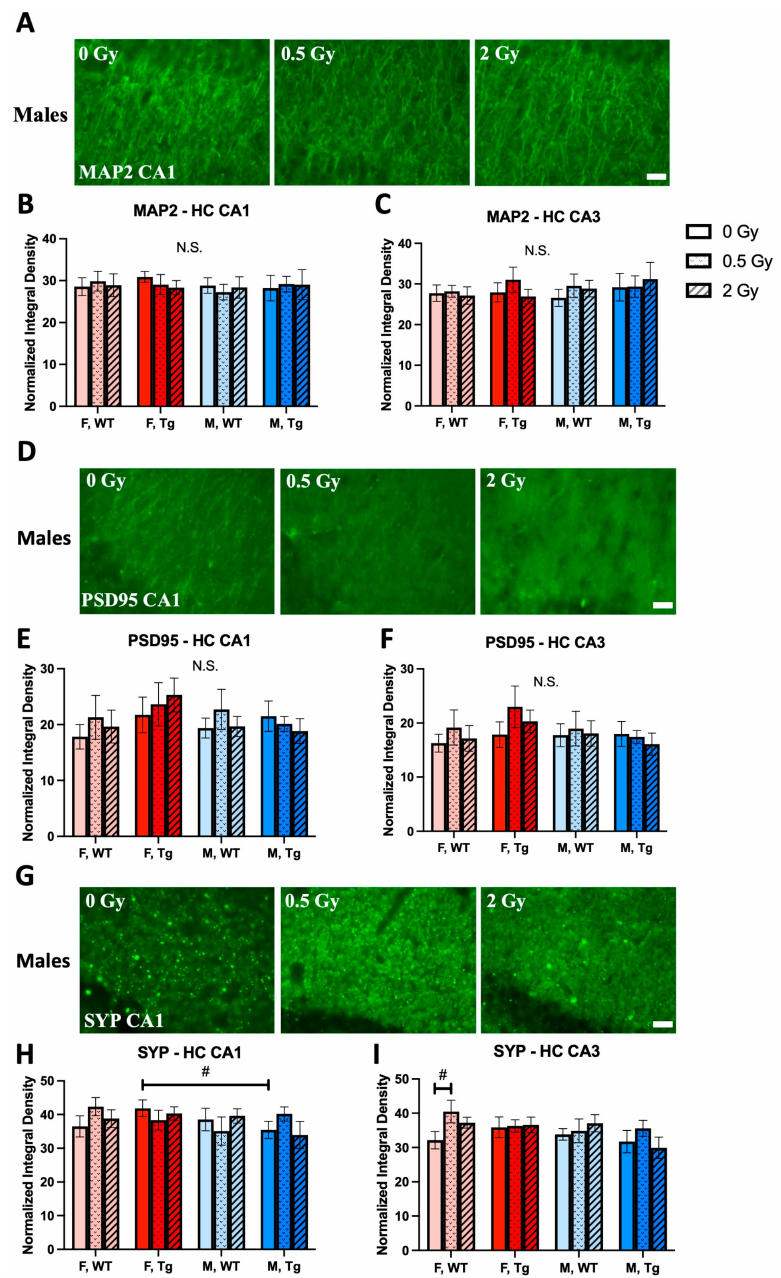
Figure 6. No late effects of proton irradiation on expressions of dendritic marker, ( A – C ) MAP2, or synaptic markers, ( D – F ) PSD-95 and ( G – I ) Synaptophysin in hippocampal CA1 and CA3 regions were observed. Immunofluorescent labeling of synaptophysin, PSD-95, and MAP2 were performed on fixed mouse brain cryosections ( n = 6–9 mice/group, 2 sections/mouse/marker). Scale bars: 100 µ m. #: p < 0.1. N.S.: not significant. Data were analyzed by three-way ANOVAs for main